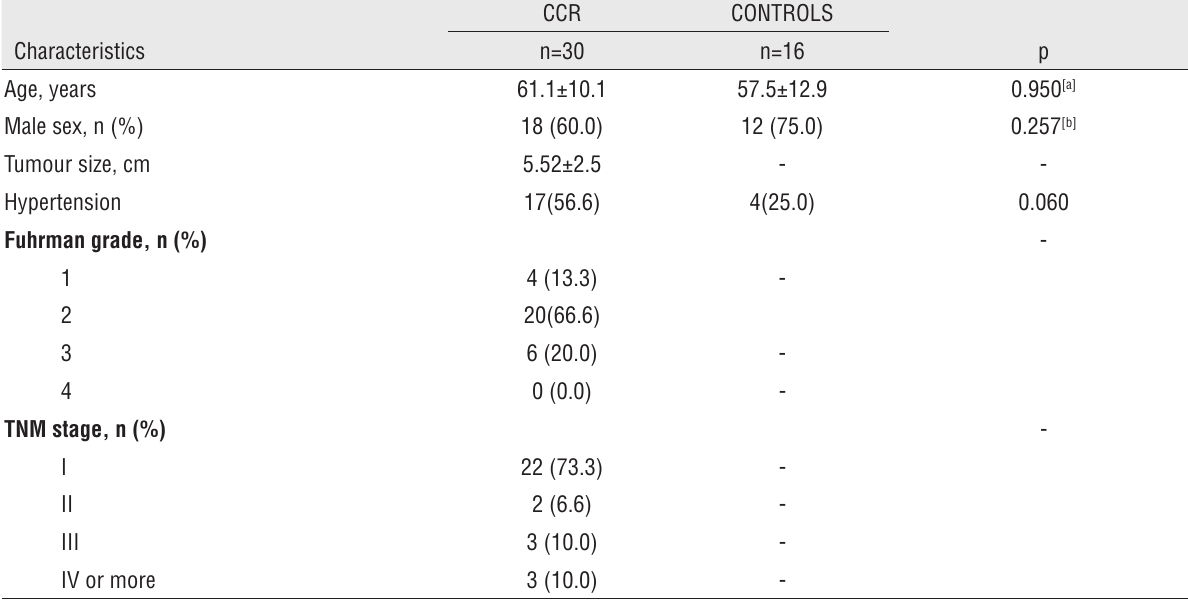
Table 1 – Patients